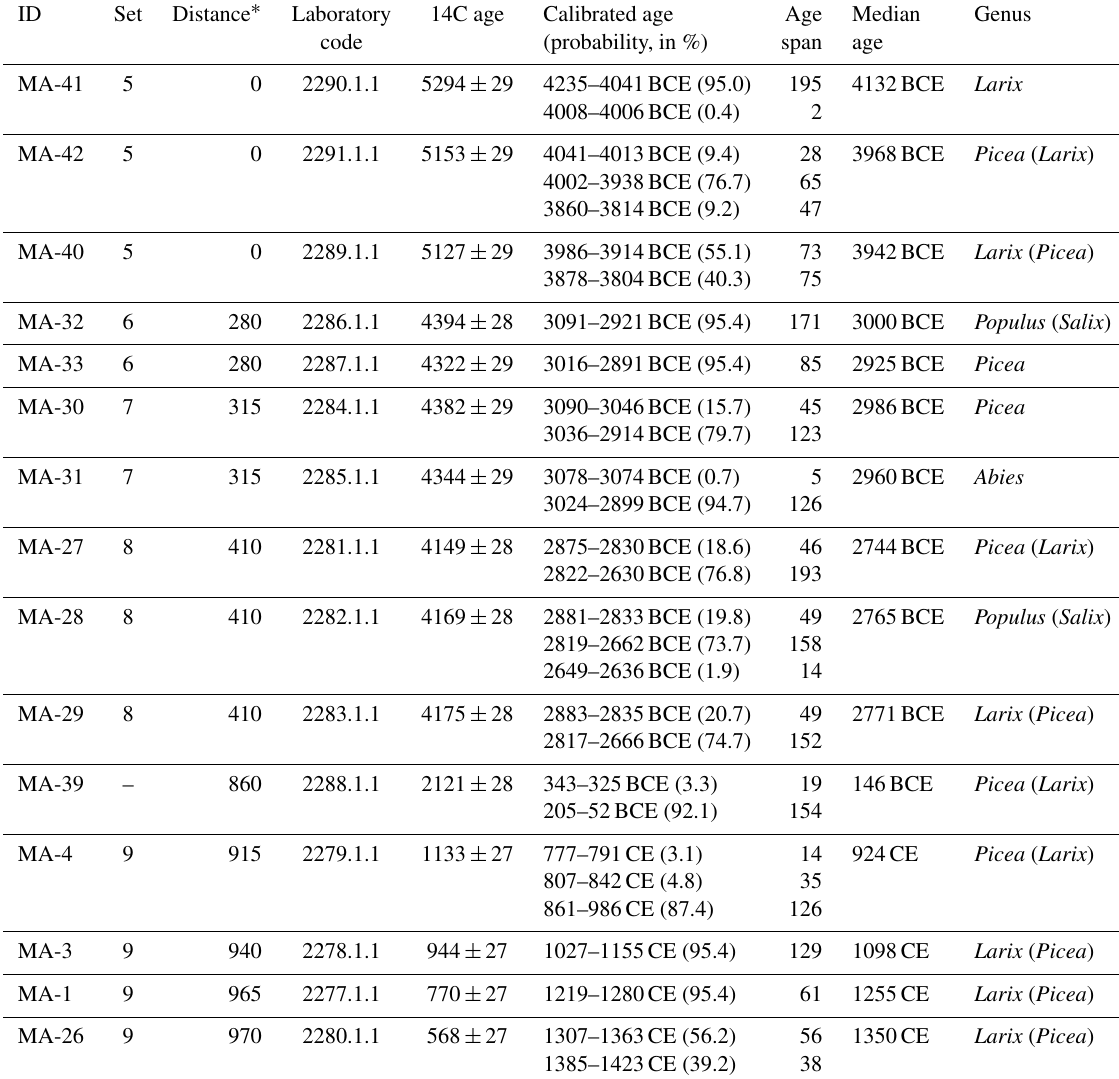
Table 2. Overview of radiocarbon samples from Makhchar